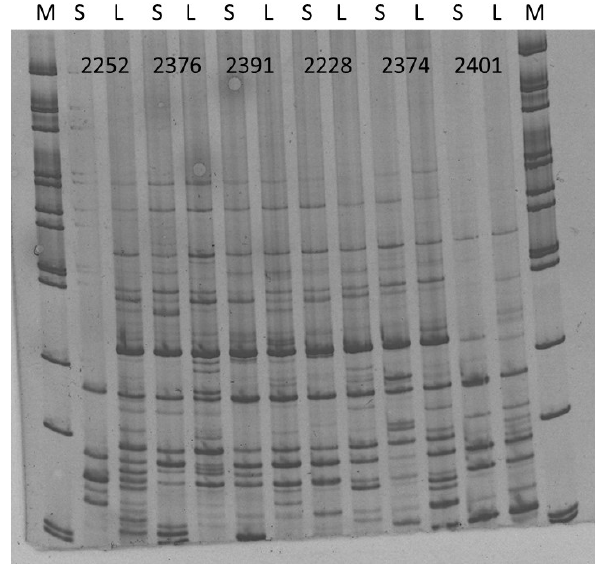
Figure 7. Obtained iPBS amplicon profiles of for Rosa canina var. squarosa A.Rau (S) and Rosa canina var. lapidicola Heinr. Braun. (L) when several markers were utilized. M—100 bp ladder. Numbers represent the codes of iPBS markers tested.